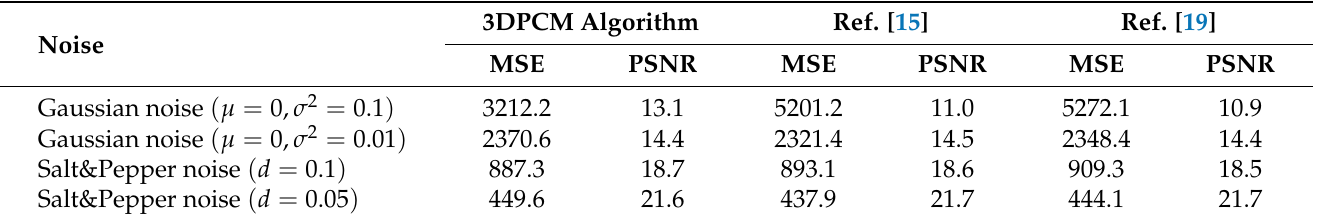
Figure 8. Deciphered image by applying multiple forms of noise to the enciphered image Lena ( 256 256 ) . × Table 9. Noise